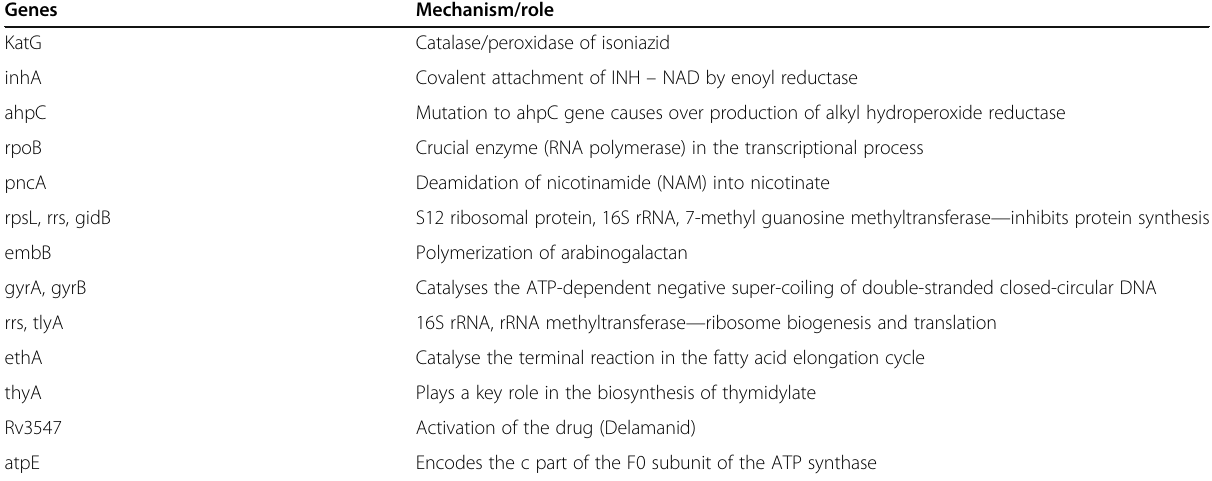
Table 4 Mechanism/role of mycobacterial genes responsible for resistance Genes